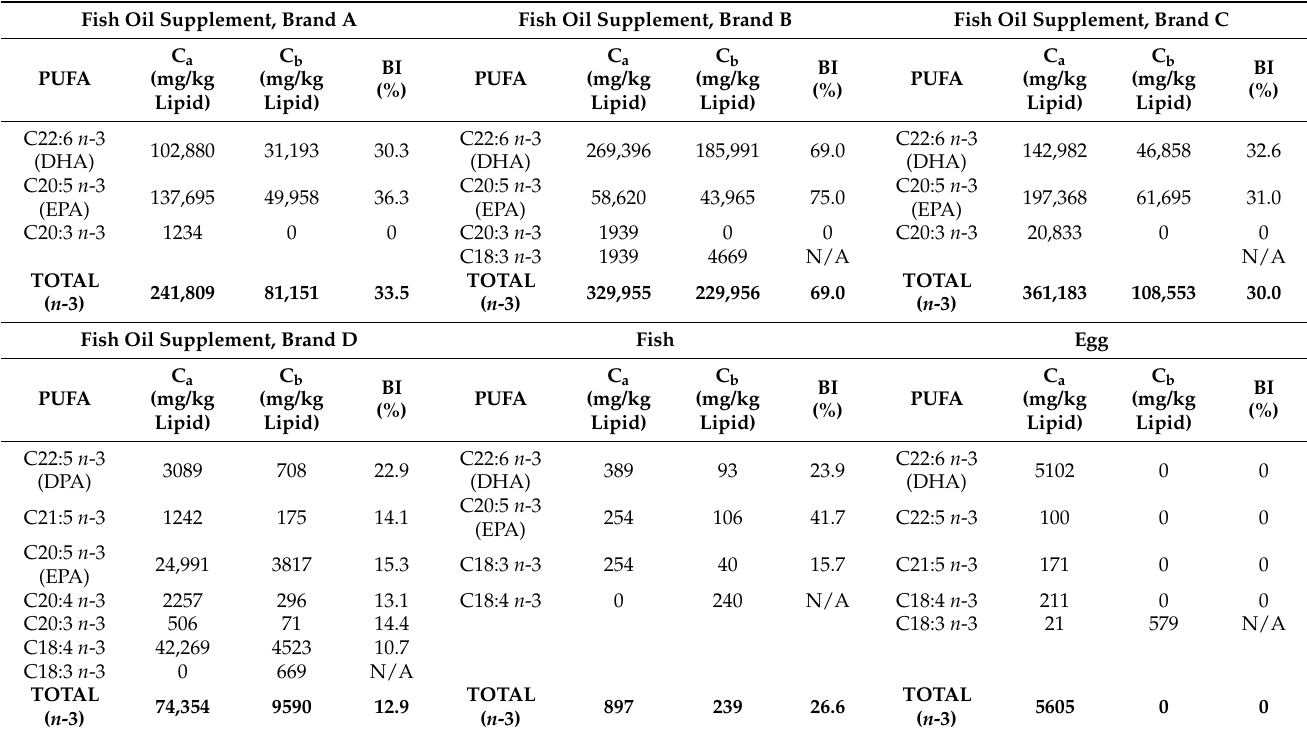
Table 3. Results of GC-FID and BI